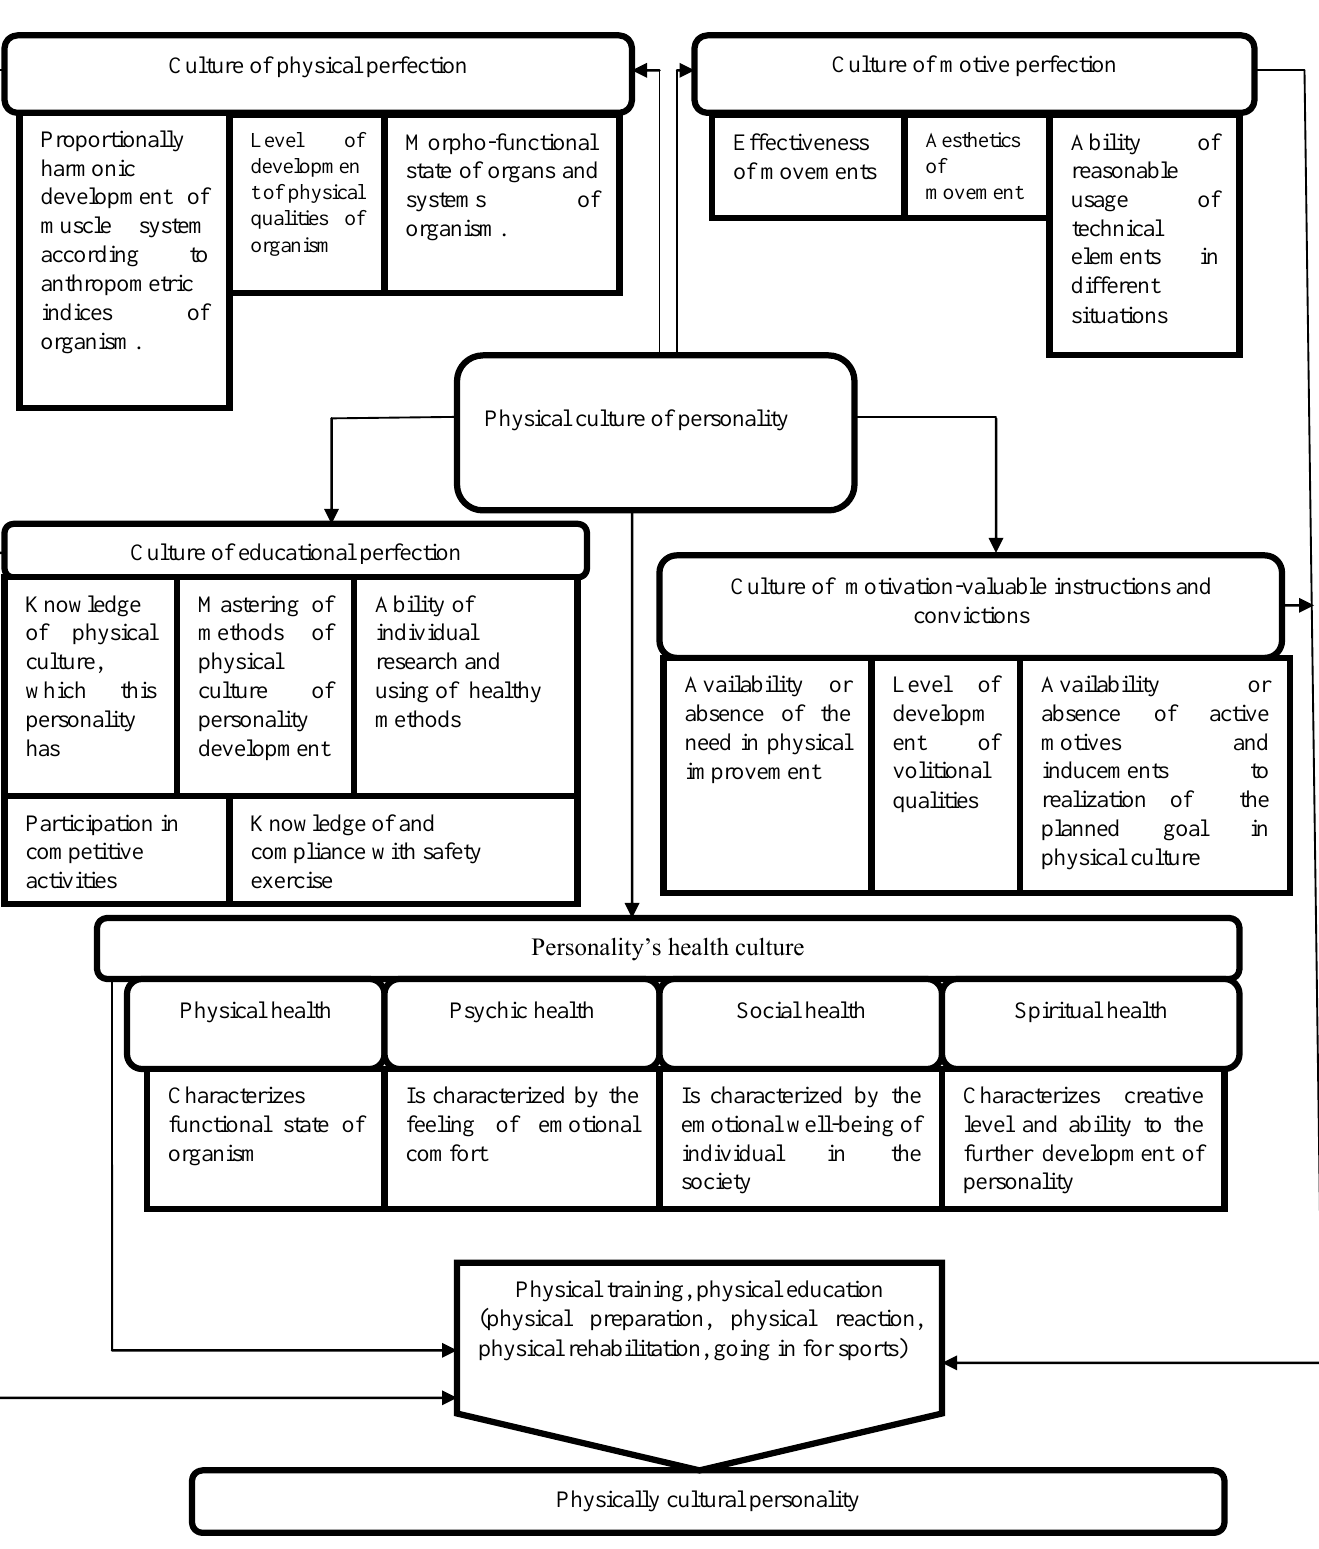
Pic. 1. Structural-contextual chart of forming of physically cultural